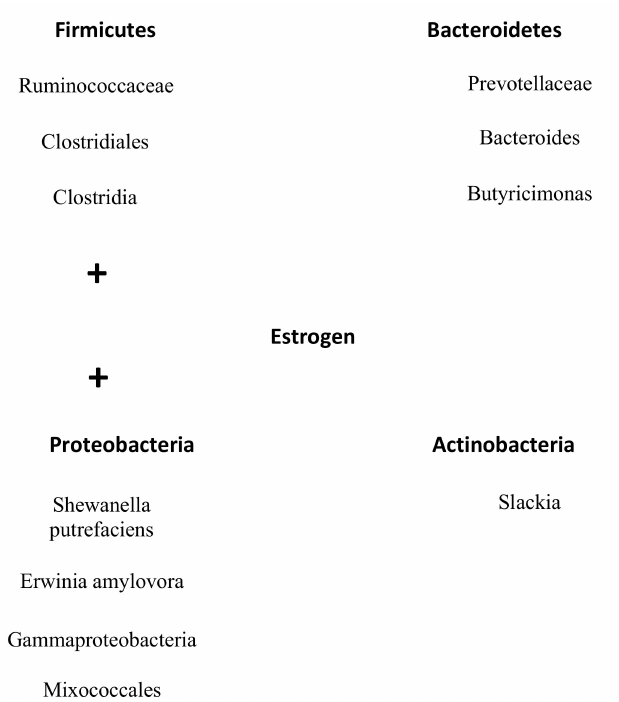
Figure 2. Overview microbes of the gut microbiome that correlates with estrogen levels. All families and genera from the phyla Firmicutes and Protobacteria positively correlate with estrogen levels. On the contrary, all documented families and genera from the phyla Bacteroidetes and Antinobacteria are negatively correlated with estrogen